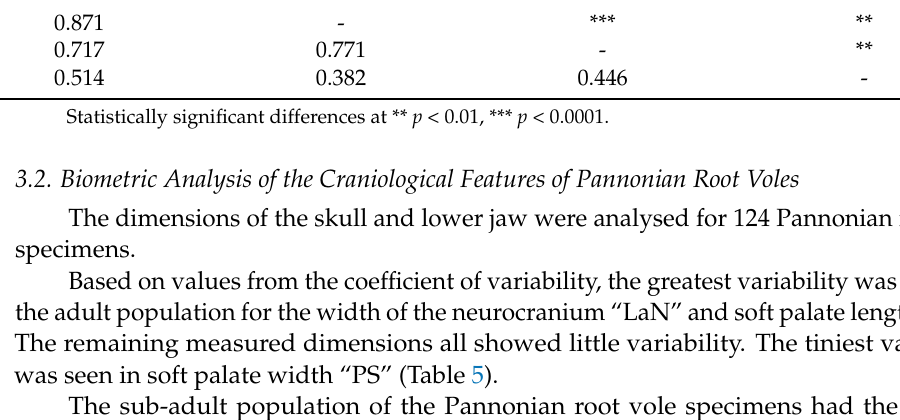
Table 4. Pearson correlation table between four somatic features. Body Weight Body